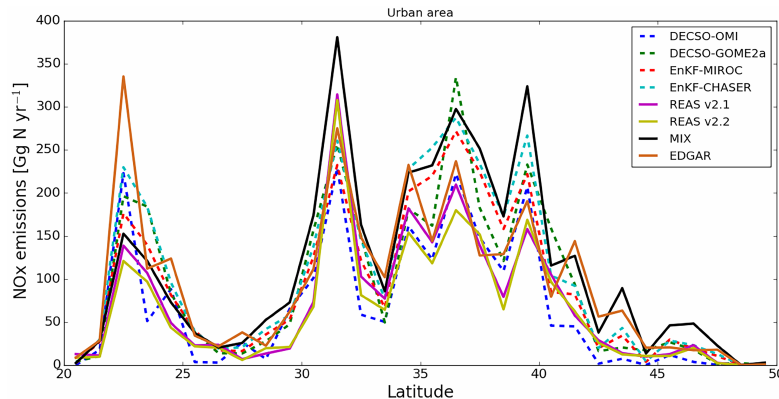
Figure 9. Latitudinal distribution of longitudinal total NO x emissions over urban areas (the red cells in Fig. 8).